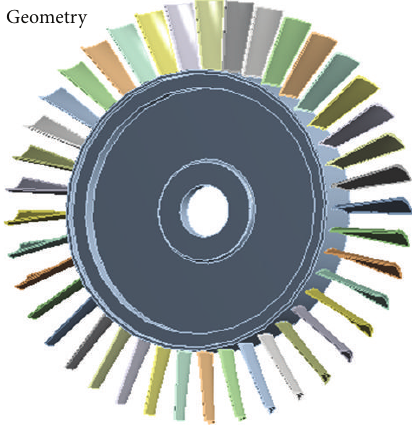
Figure 2: Structure model of